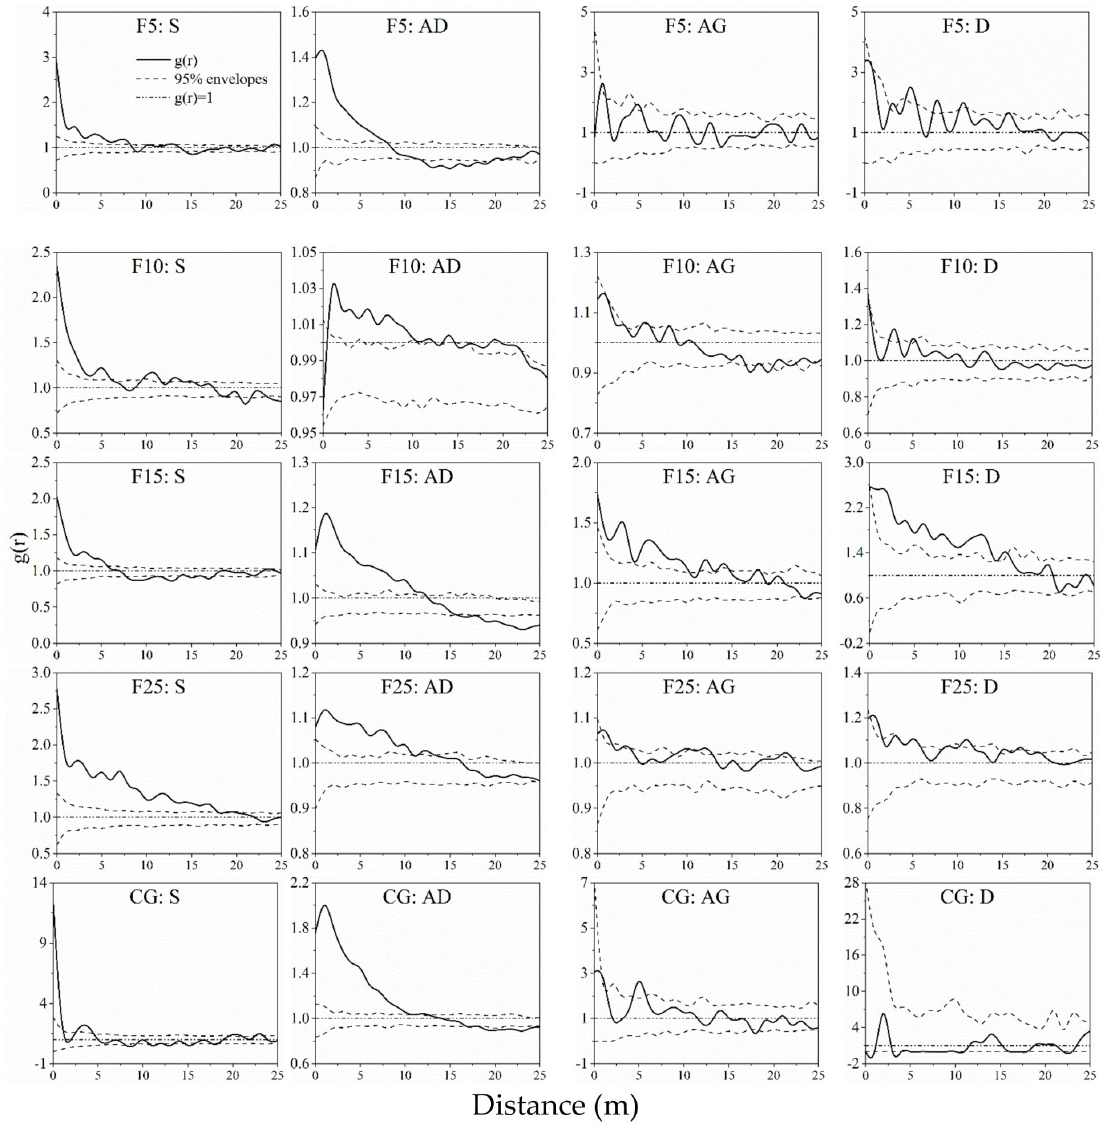
Figure 5. Univariate spatial autocorrelation of four age classes of the A. ordosica population on the F5, F10, F15, F25, and CG plots. S: seedling group, AD: adult group, AG: aging group, and D: dead group. F5 (enclosed 5 years), F10 (enclosed 10 years), F15 (enclosed 15 years), F25 (enclosed 25 years), and CG (continuously